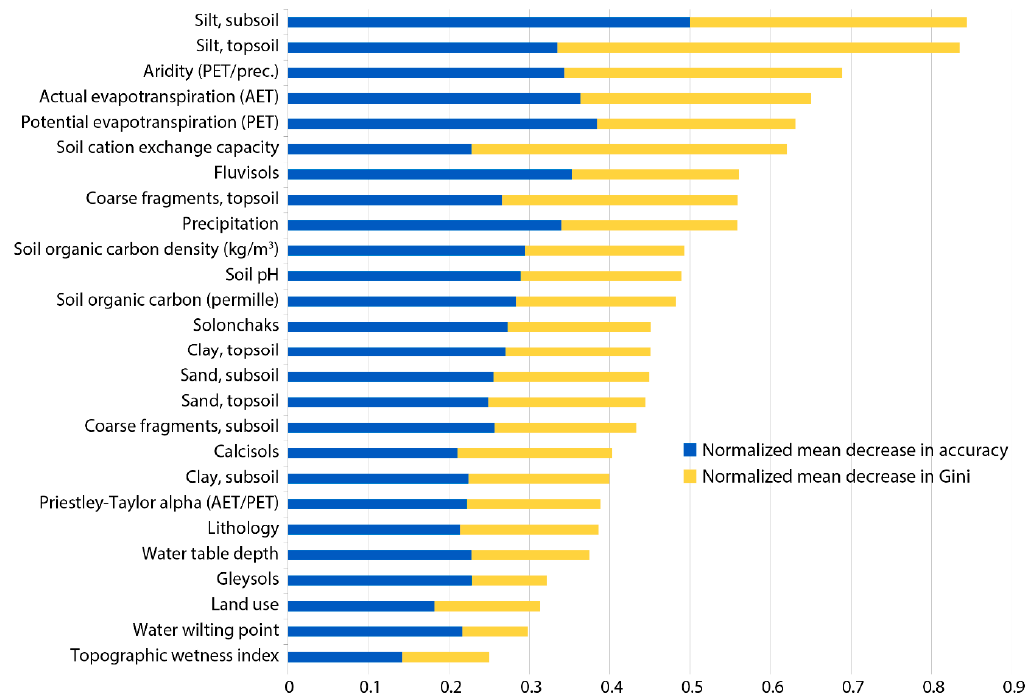
Figure 3. Normalized variable importance in terms of mean decrease in accuracy and mean decrease in Gini as calculated on the test dataset. Both decrease in accuracy and decrease in Gini were normalized by their respective greatest values (see Table S1).